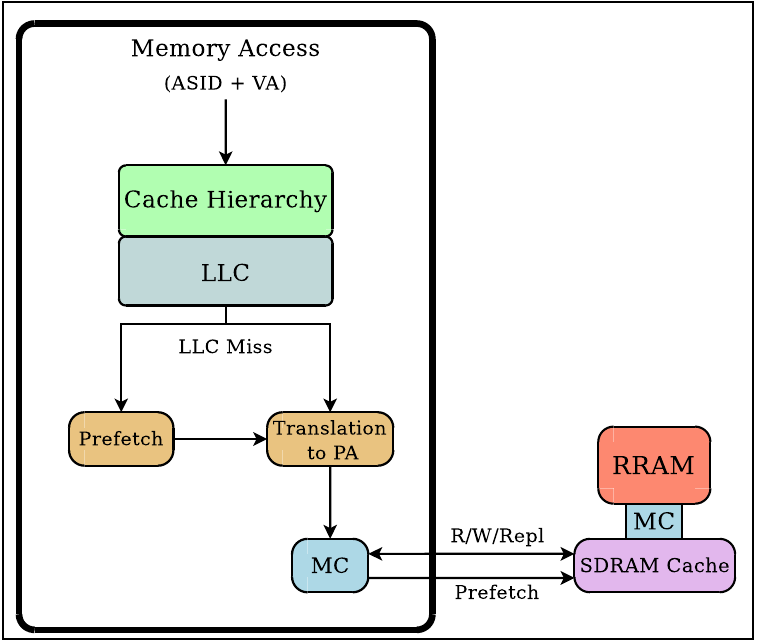
Fig 5. Schematic architecture. Proposed virtual address ( VA ) based architecture for off-chip prefetching. The use of VA allows the prefetcher to exploit all the locality information at the cost of increase memory and energy use to store tags and ASID information. The number of VA to PA translations is greatly reduced due to the positive effect of the cache hierarchy in reducing off-chip accesses. Off-chip prefetchers move data/instructions in advance from NVM - RAM to DRAM C